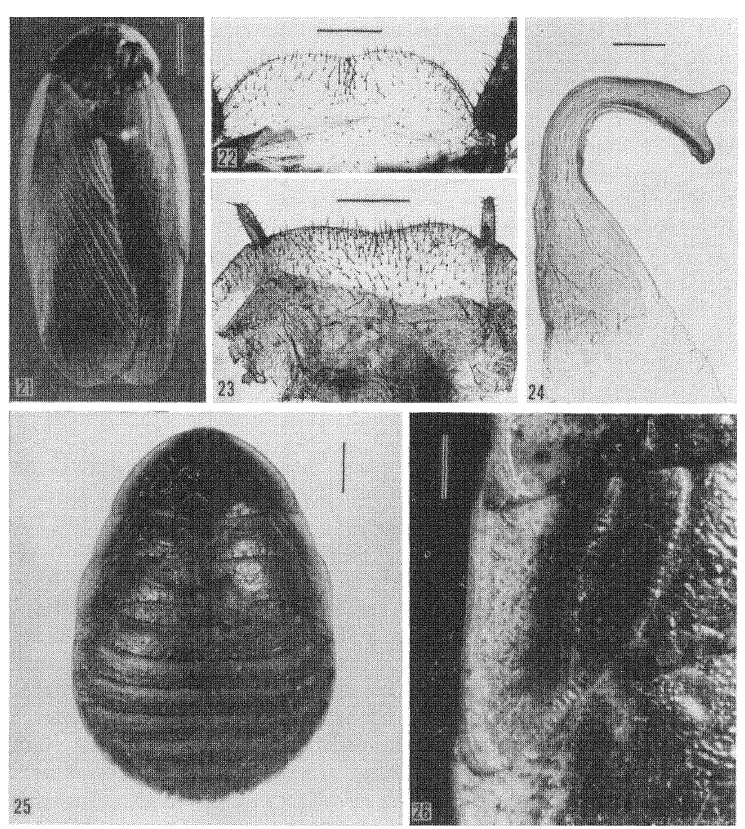
Figures 21-26. Calolampra ignota. 21-24. (1 WAM), holotype, Bu- long, W. A. 21. Adult. 22-23. Supra-anal plate and hypandrium. 24. R2 of genitalia. 25. ? (179 L), paratype, Norseman, W. A. 26. Tegmen of female shown in figure 25. Scale: Figs. 21, 25 mm; Figs. 22-23 0.5 mm; Fig. 24 0.1 mm; Fig. 26